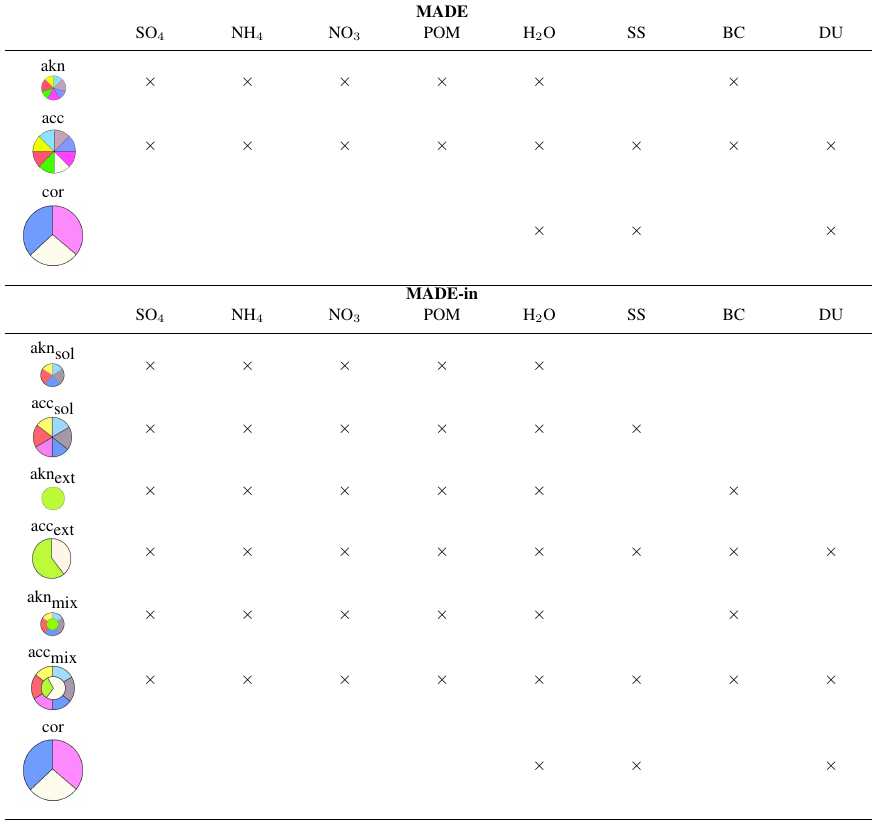
Table 1. Chemical composition of the modes in MADE and in MADE-in. POM stands for particulate organic matter, BC for black carbon, DU for mineral dust and SS for sea salt. The externally mixed modes (aknext, accext) contain some amount of soluble material. When this amount is large enough the externally mixed modes are transferred to the internally mixed ones (aknmix, accmix)